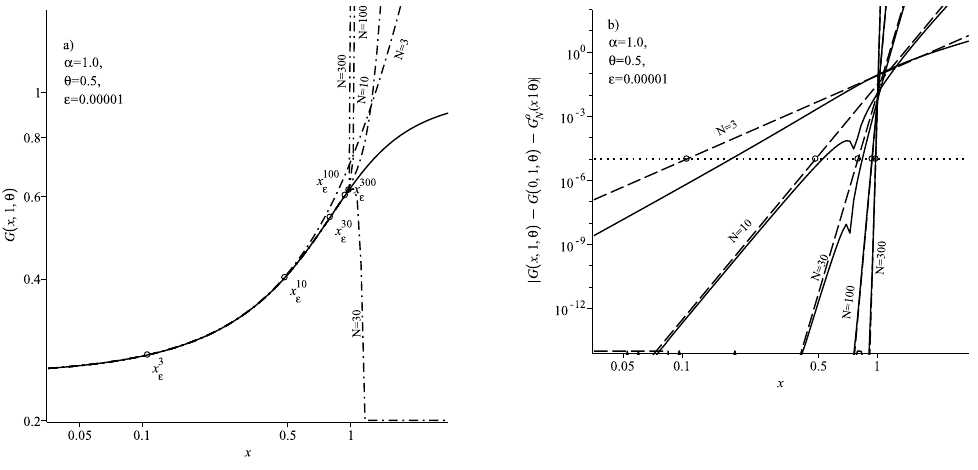
Figure 6. ( a ) Distribution function G ( x , α , θ ) for the parameter values shown in the figure. The solid curve is Formula (8), dash-dotted curves are the expansion (37) for different values of the number of N summands in total. Circles are the position of the threshold coordinate (49) for each value of N . ( b ) The graph of the absolute error of calculating the distribution function using the expansion (37) for the case given in Figure ( a ). Solid curves are the exact value of the absolute ( 1 − θ ) − G 0 ( x , α , θ ) | , dashed curves are the estimate (39), and the dotted line error | G ( x , α , θ ) − 1 N 2 demonstrates the position of the specified accuracy level ε . Circles show the location of the threshold coordinate (49) for the specified values of N